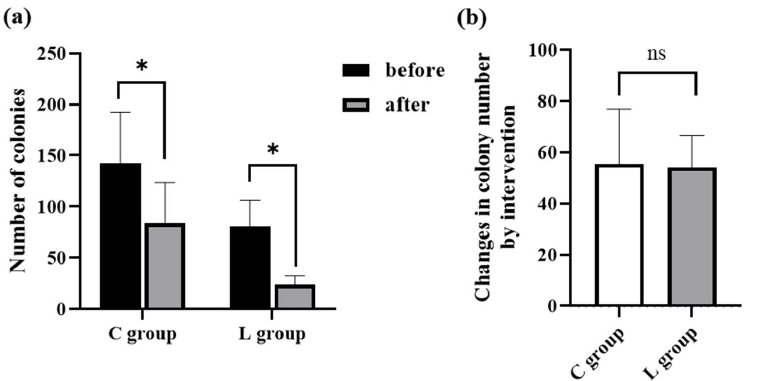
Figure 3. Changes in the number of aerobic colonies by footbath with or without Lu essential oil (n = 20). ( a ) Number of aerobic colonies before and after the intervention in the C group and L group. Before: Before taking a footbath, after: after taking a footbath. * p < 0.05. ( b ) Changes in colony num- ber of the C and L groups, which were calculated by subtracting the colony number after interven- tion from that before the intervention. ns means p >